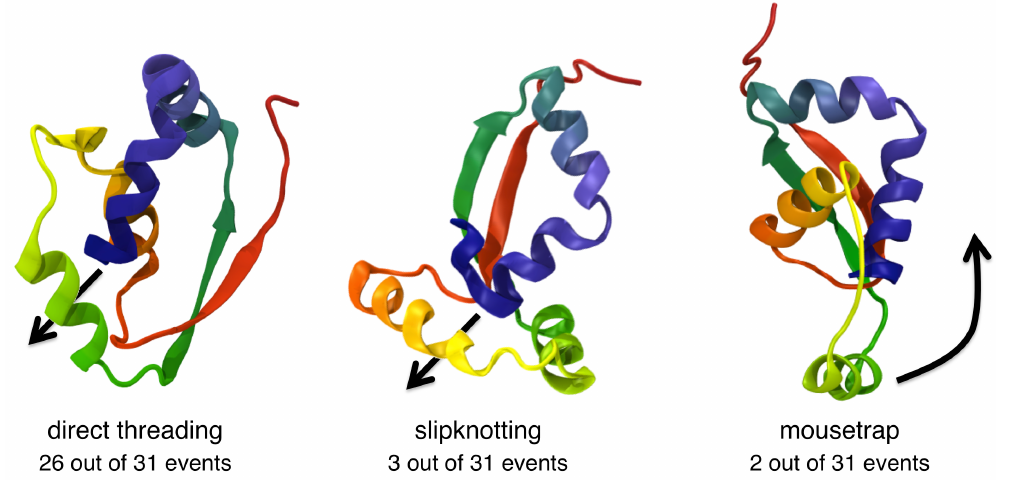
Figure 5. Schematic representation of the observed knotting mechanisms for